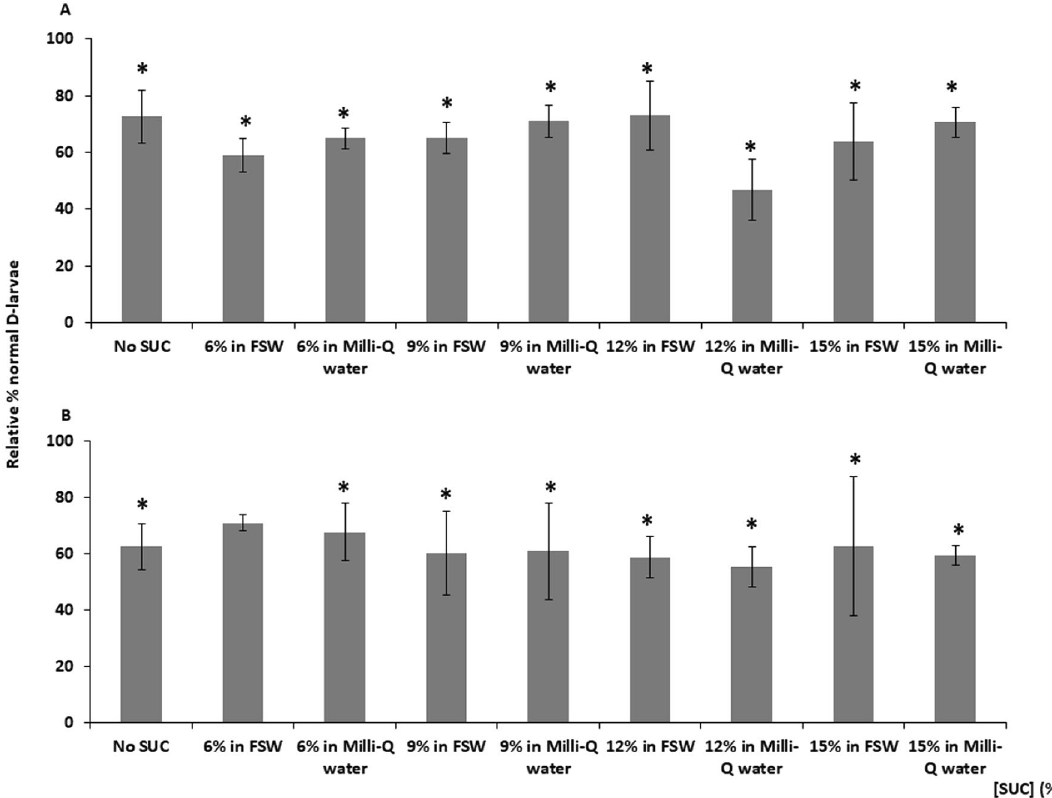
Figure 4. Relative percentage of M. galloprovincialis normal D-larvae compared to control group developed from cryopreserved trochophores ( A ), 72 h-old D-larvae ( B ), diluted with increasing sucrose (SUC) solutions in Milli-Q water or Filtered Sea Water (FSW) for CPA removal once samples were thawed. Results are expressed as Mean ± Standard Deviation (SD), n = 100, 3 replicates per treatment. Asterisk shows significant differences with control group (p <